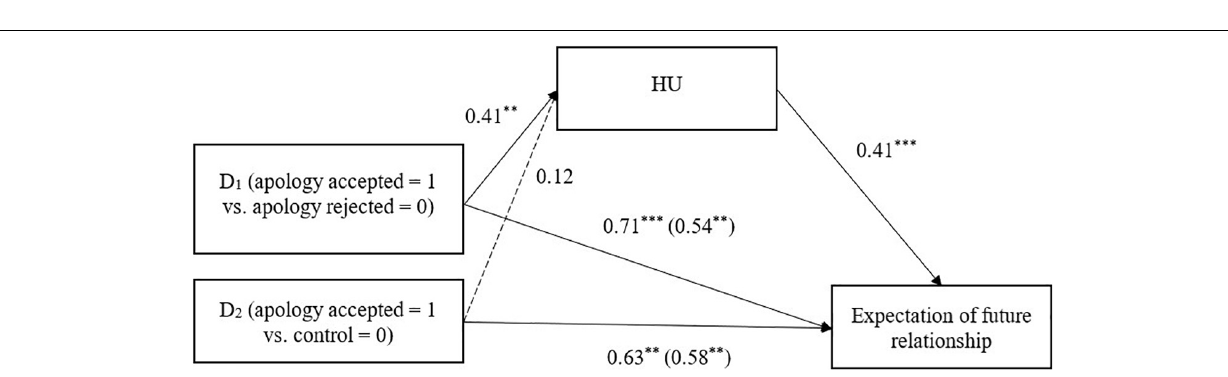
FIGURE 6 | HU mediating the relationship between perceived apology acceptance and expectation of a future relationship (Study 2). Unstandardized coefficients are presented. Coefficients in parentheses denote direct effects after controlling for indirect effects. ∗∗ p < 0.01, ∗∗∗ p < 0.001.